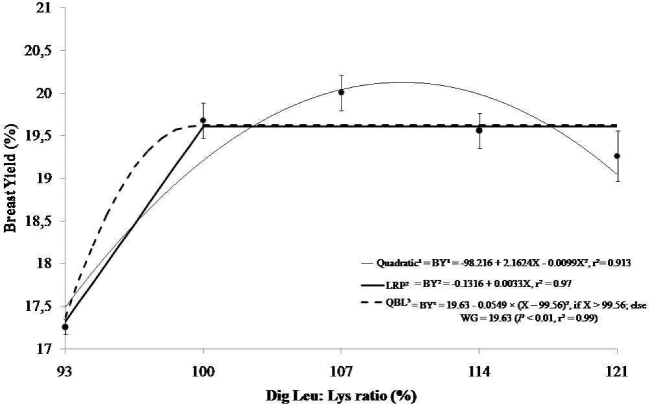
Modeled effects of dietary digestible Leu:Lys ratios (%) on breast yield of broiler chicks in the feeding period from 8 to 17 d of age. The digestible Leu to digestible Lys ratios by quadratic regression on body breast yield (y = –98.216 + 2.1624x + 0.0099x2, r2 = 0.91) produce a maximal digestible ratio estimate of 110%, or 105% at 95% of this response. Using the LRP model, an optimal ratio of 99% was estimated, with a plateau WG response of 19.51 g and an increasing slope to that plateau (y = –0.1316 + 0.0033x, r2 = 0.93). The QBL model was also significant (P < 0.01) for body BY, with a plateau response of 19.63 g [BY (g) = 19.63 – 0.0549 × (X – 99.56)2, if X > 99.56; otherwise, BY (g) = 19.63 (P < 0.01, r2 = 0.99].